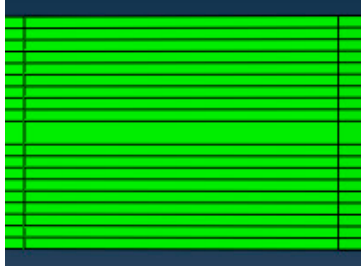
Figure 2. Layered model of an FGPM thin circular plate.